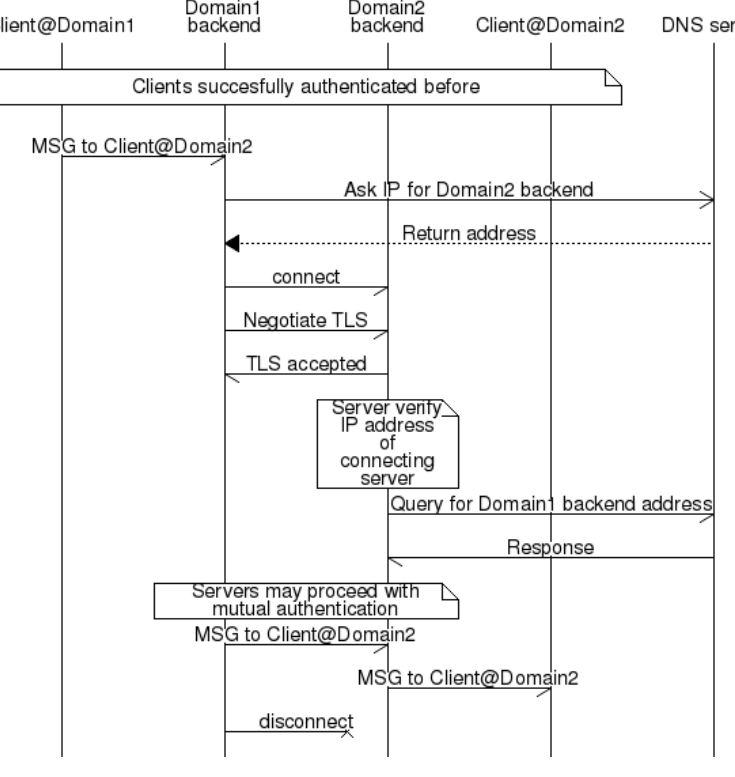
Figure 11. Server to server interdomain